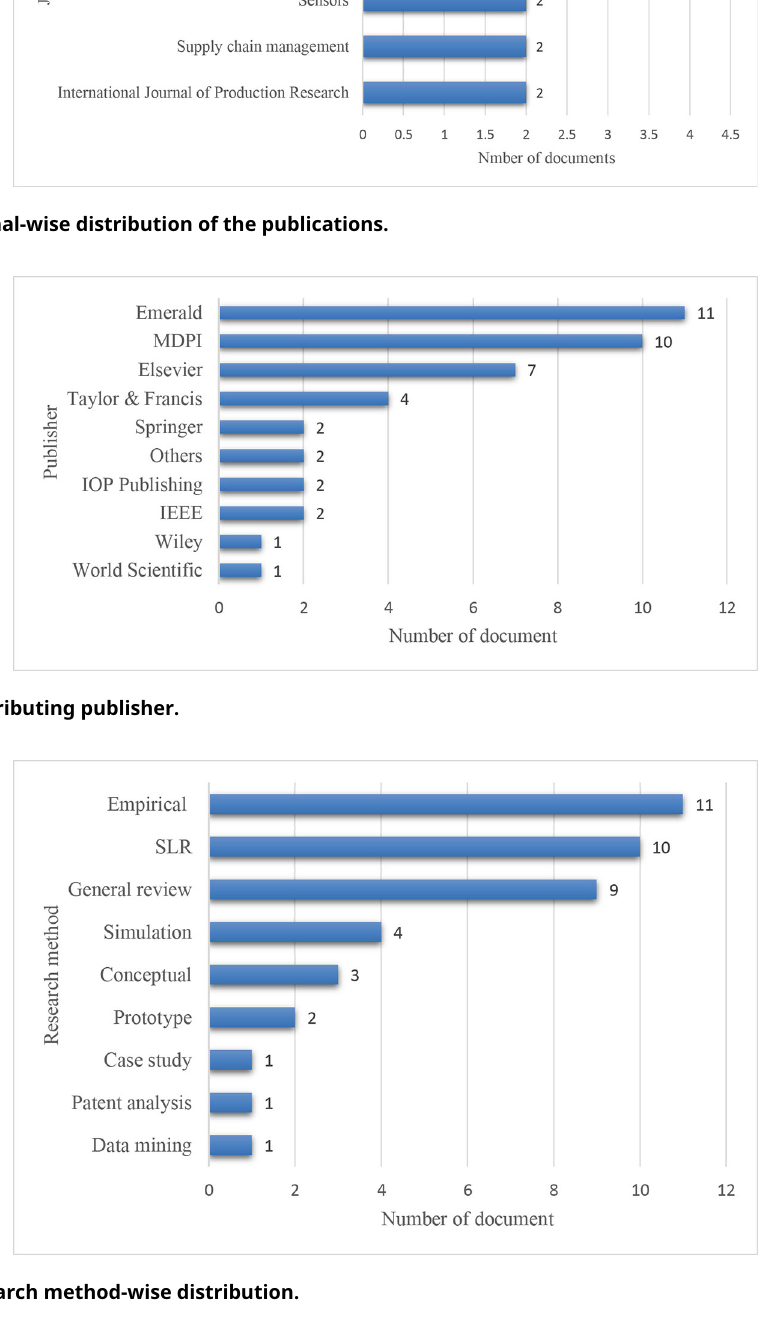
Figure 7. Research method-wise